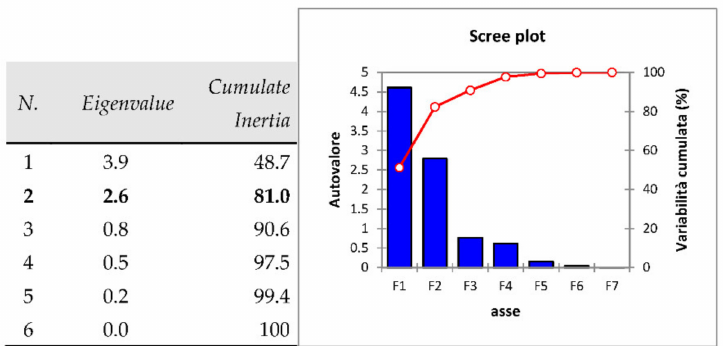
Figure 2. Principal Component Analysis (PCA), eigenvalues, explained and cumulate inertia. High Pearson’s correlation coefficient was exhibited among Chl a, Carotenoid (C) and Protein (P). Significant correlations were also shown among Chl a, carotenoids, and neo-formed shoots (n) (0.6), while MDA was linked to node (n) (0.5) (Table